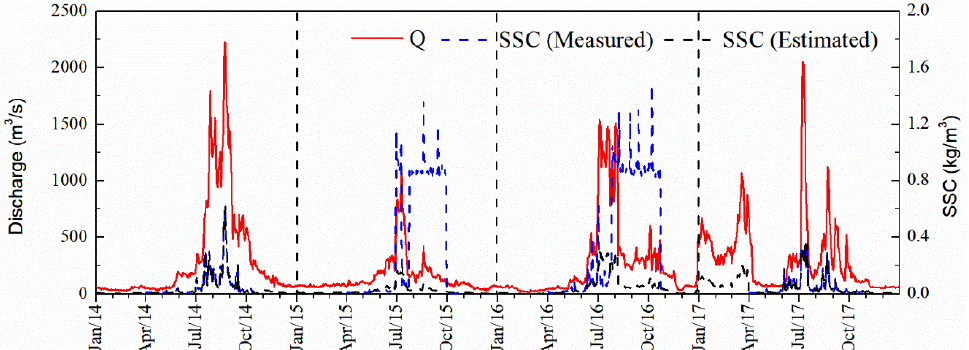
Figure 2. SSC and flow discharge at the Lhasa Station.